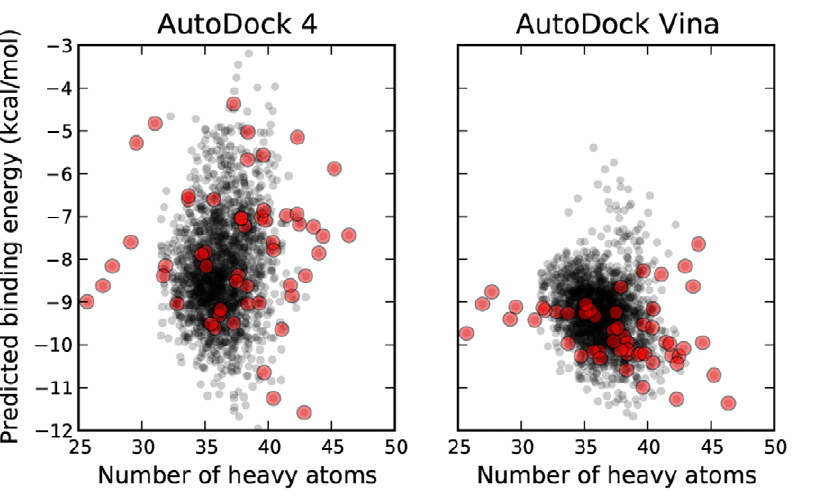
Figure 8. Predicted binding energies for DUD compounds with HIV protease as a function of the number of heavy atoms in the compound. Active compounds are highlighted in